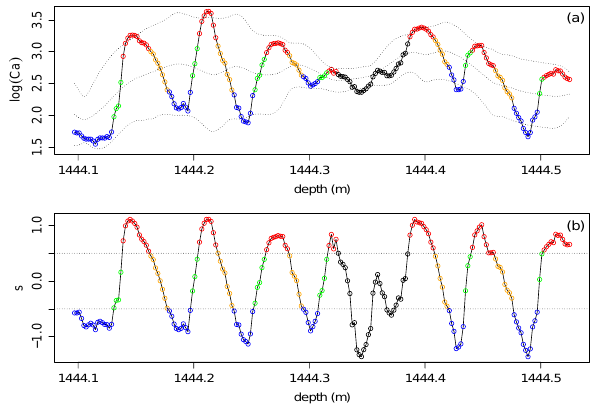
Fig. 10. A stretch of the classified log Ca signal (second thinning) from the NGRIP ice-core (1444.10–1444.53m), for ν = 0 . 5. Points within an issue are black, points within peaks coloured red, de- scending points orange, troughs blue, and ascending points green. (a) The log signal with µ and µ ± σ shown as dotted lines. (b) The standardised signal s